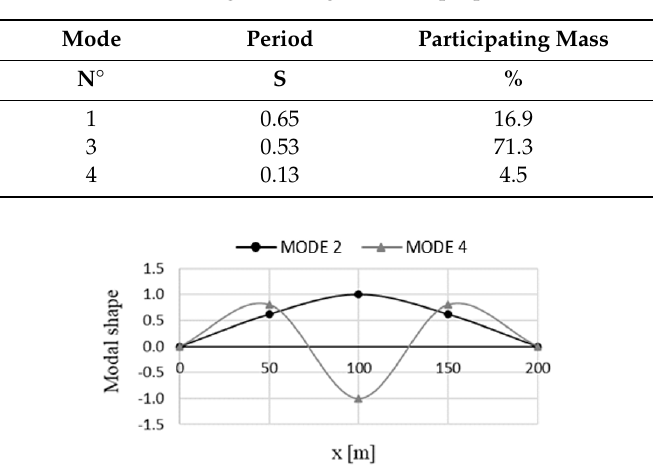
Figure 10. Regular bridge—mode shapes (transverse direction). Table 4. Irregular bridge—modal properties.